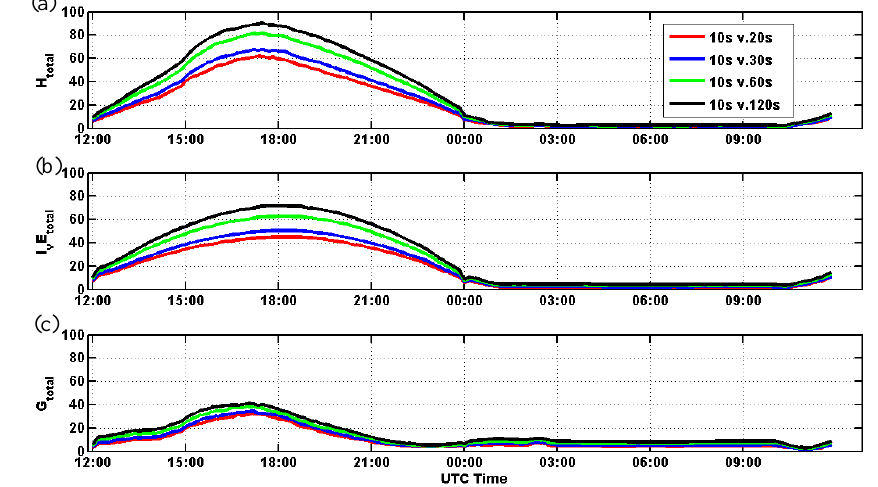
Fig. 11. RMSD of selected surface heat flux quantities over the fourth model grid for comparison of case 10s and others of differing land cover resolution (in arc-seconds), averaged over all available data in Period 1 and Period 2. RMSD is shown versus time of day (UTC time) in units of Wm − 2 for total surface sensible heat flux (a) , total surface latent heat flux (b) and total ground heat flux (c)